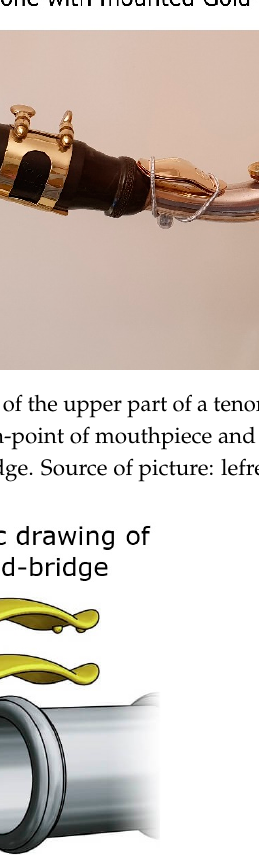
Figure 2. Schematic drawing of the design of a “sound bridge” consisting of two equally